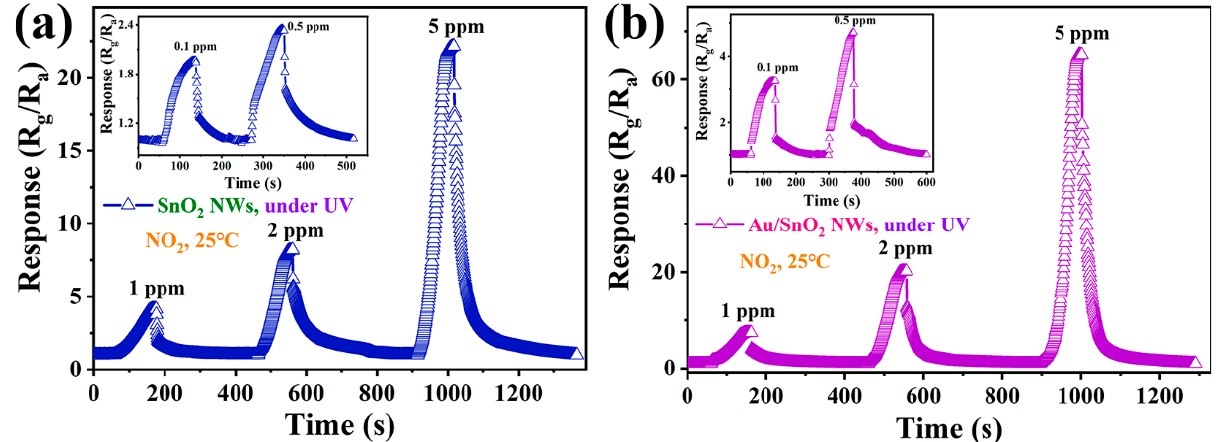
Figure 7. Dynamic response–recovery curves of sensors based on ( a ) SnO 2 and ( b ) Au/SnO 2 NWs to NO 2 with concentrations in the range of 0.1–5 ppm at RT under UV irradiation (0.42 mW/cm 2 ).